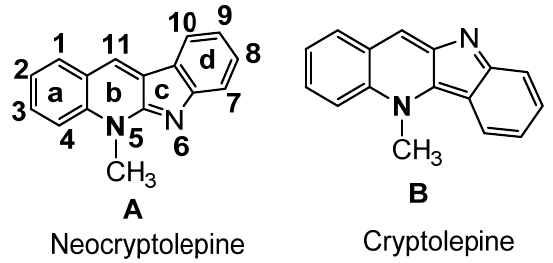
Figure 1. Indoloquinoline from CryptolePis Sanguinolenta.